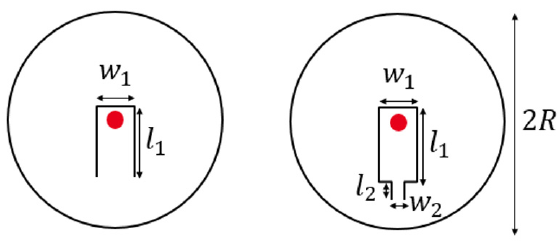
Figure 3. Diagram of the cantilever-based diaphragm (left) and the hinged cantilever-based diaphragm (right). Red spots indicate the probe laser location.